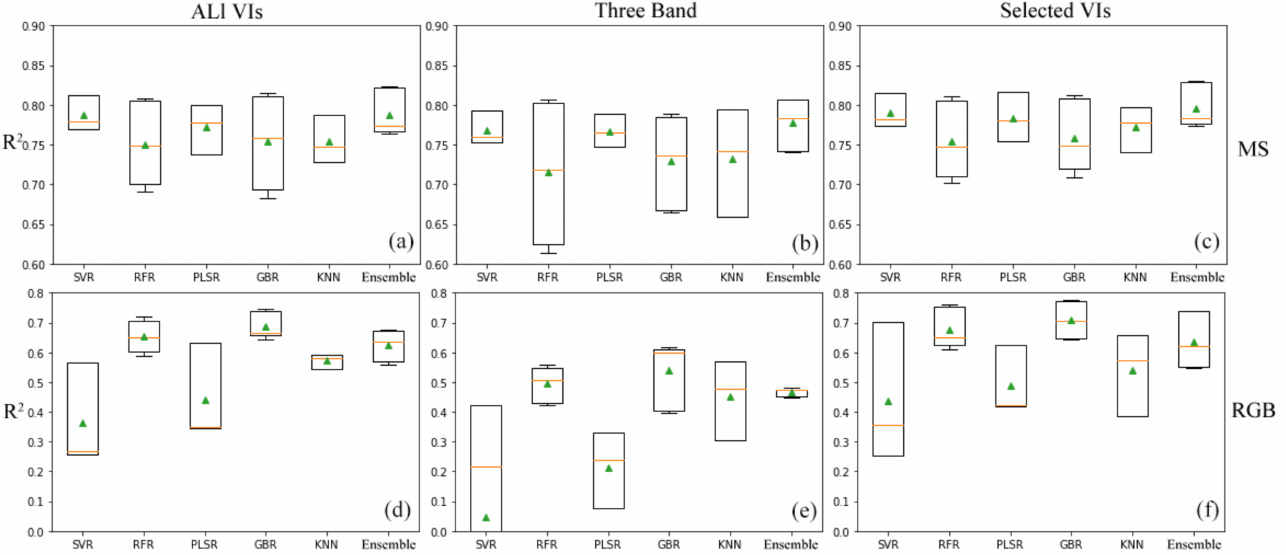
Figure 13. Performance of different models in 0.007 m GSD MS datasets with ( a ) all VIs, ( b ) three band data and ( c ) selected VIs, and RGB datasets with ( d ) all VIs, ( e ) three band data and ( f ) selected VIs.